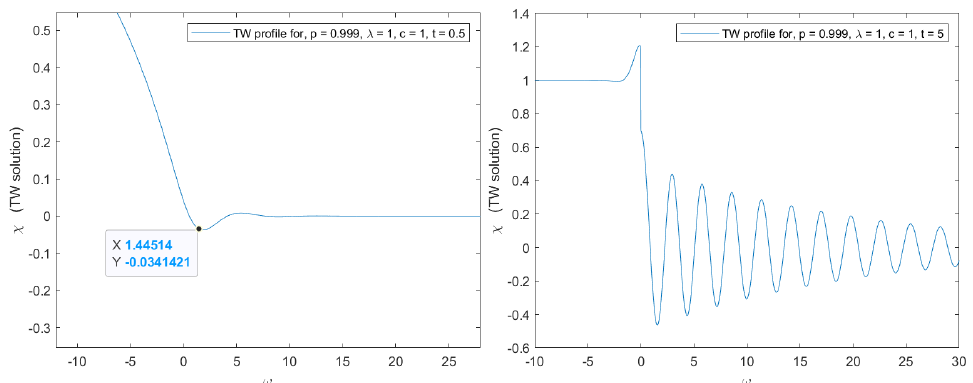
Figure 11. For a quasi-Lipschitz reaction, solutions keep oscillating for t >